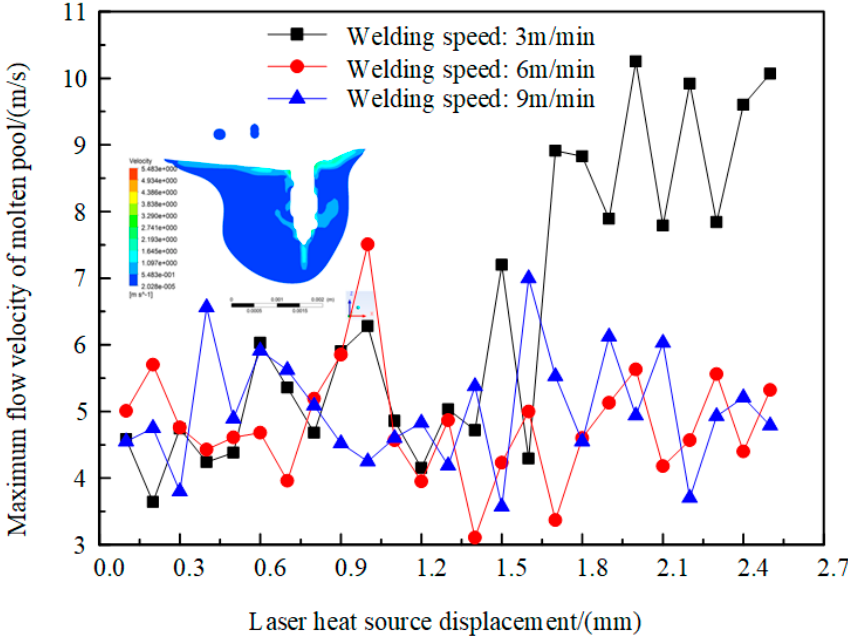
Figure 12. Relationship between laser source displacement and maximum flow velocity of the molten pool.